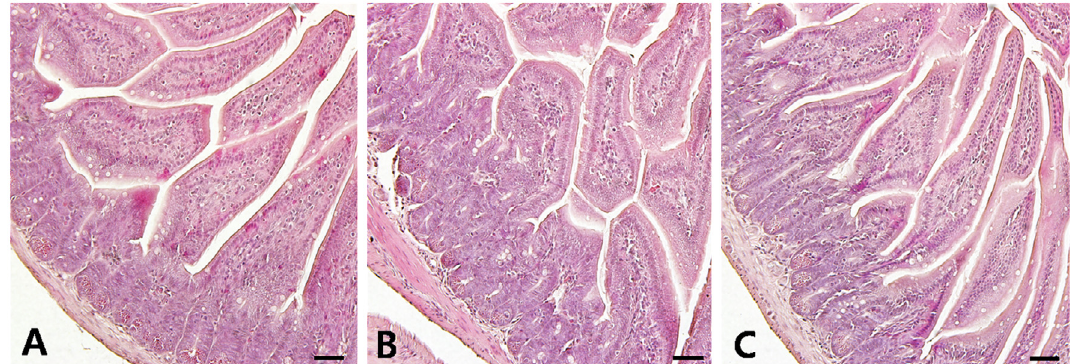
Figure 3. Representative photos of the small intestines of adult mice fed with vehicle (A) and Kudoa septempunctata spores (1.35 · 10 7 spores/mouse) sacrificed at 6 h (B) and 12 h post ingestion (C). Histological findings of the small intestines of all experimental mice revealed no pathological changes in the intestinal villi as well as in the lamina propria of intestines. A–C: Haematoxylin and eosin- staining. Scale bars = 50 l